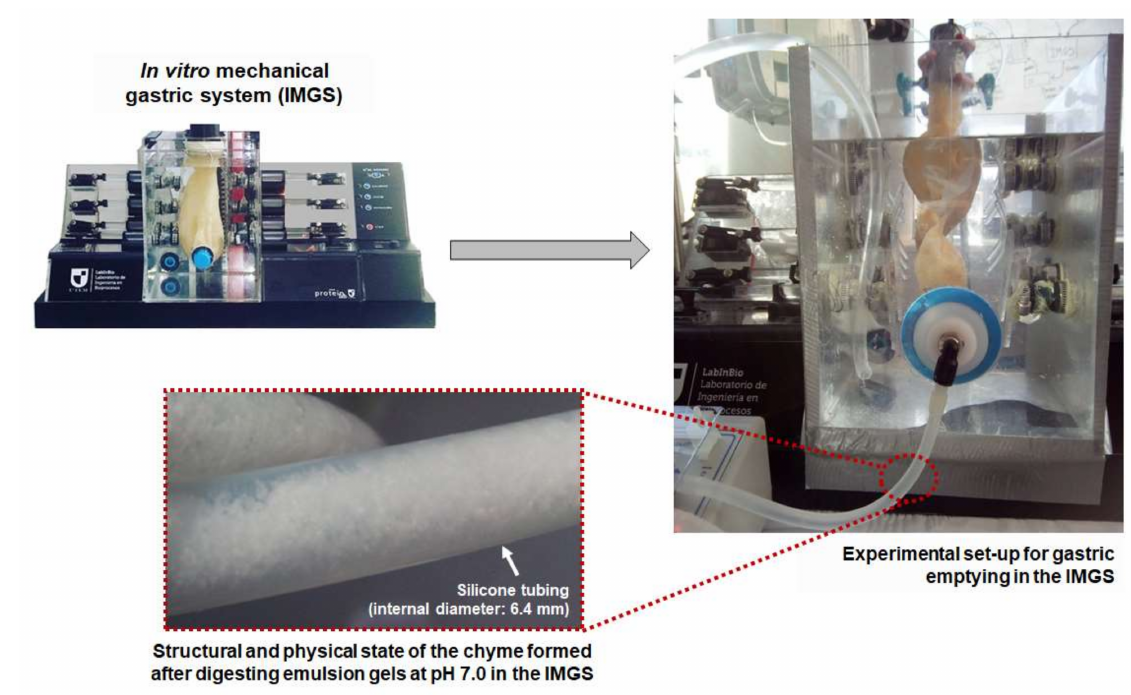
Figure 6. Representative scheme of the gastric emptying process in the IMGS and the chyme formed by digesting emulsion gels at pH 7.0 and emptied into the intestinal vessel for subsequent